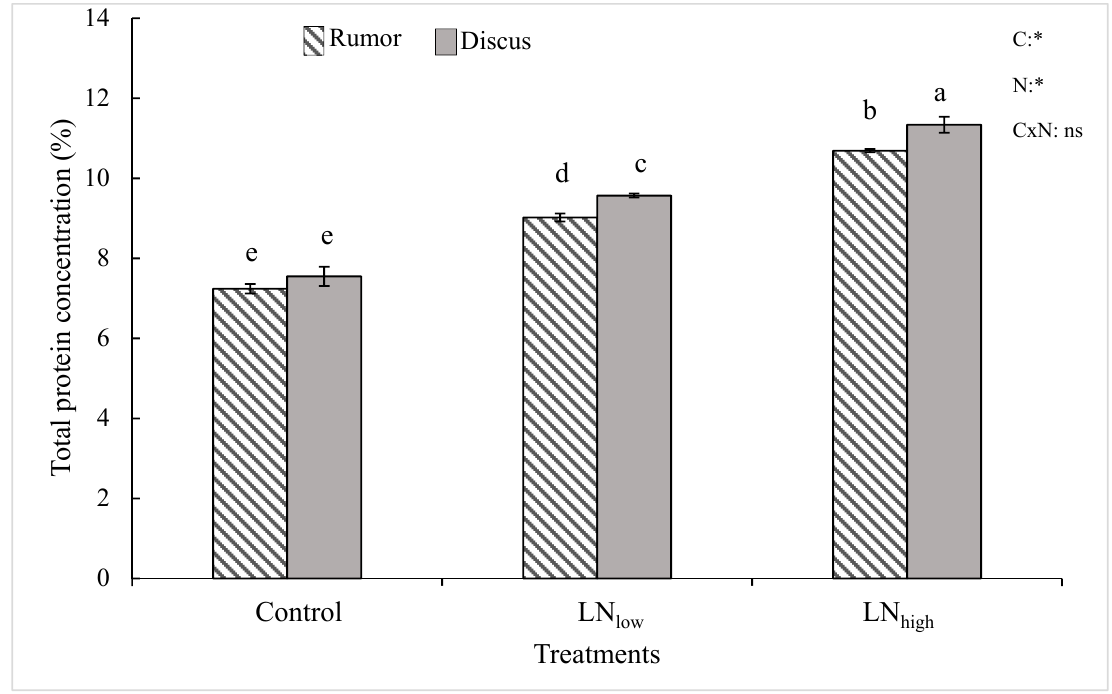
Figure 3. Total protein concentration (% of dry weight) in response to late application of N fertilizers (Control, LN low , LN high ) for the two cultivars Rumor and Discus. Bars represent mean values ± SE ( n = 3). Different small letters indicate significant differences between all treatment combinations ( p ≤ 0.05). Two-way ANOVA results are shown in the upper right corner of the diagram. C: cultivar; N: different fertilizer treatment; CxN: Interaction between cultivar and different fertilizer treatment; ns: not significant; *: significant effect.